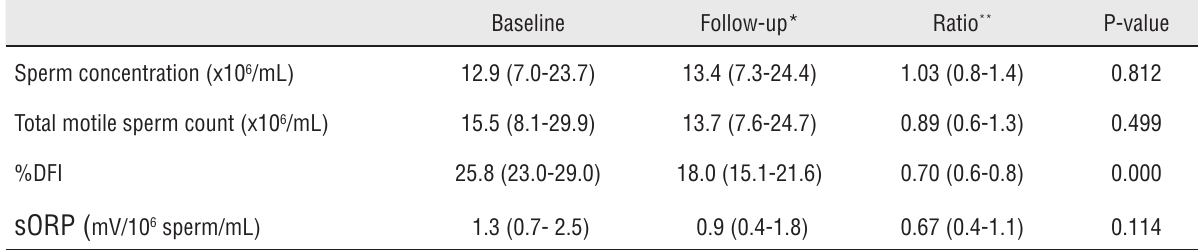
Table 1 - Semen parameters, sperm DNA fragmentation index (DFI) and seminal static oxidation-reduction potential (sORP) after 3-month lifestyle intervention and antioxidant therapy in 31 infertile men with